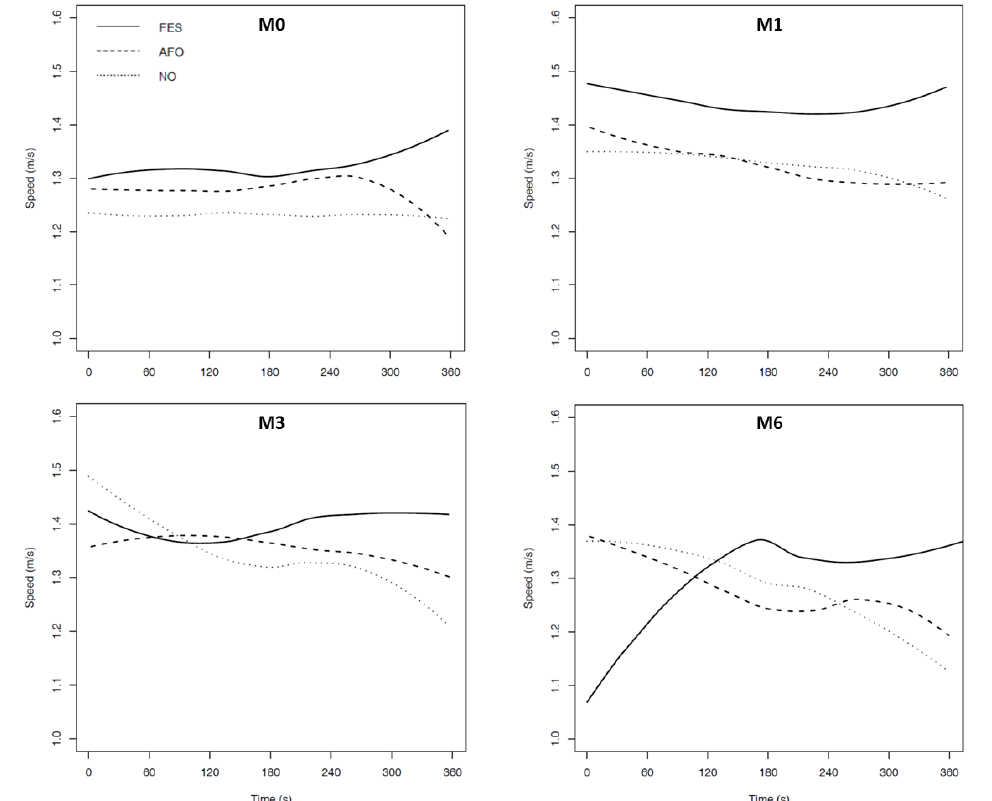
Figure 1. Gait speed evolution during the 6-MWT with NO (without any device), AFO (ankle-foot orthesis), and FES (functional electric stimulation) conditions at baseline (M0) and after 1 (M1), 3 (M3), and 6 (M6) months.